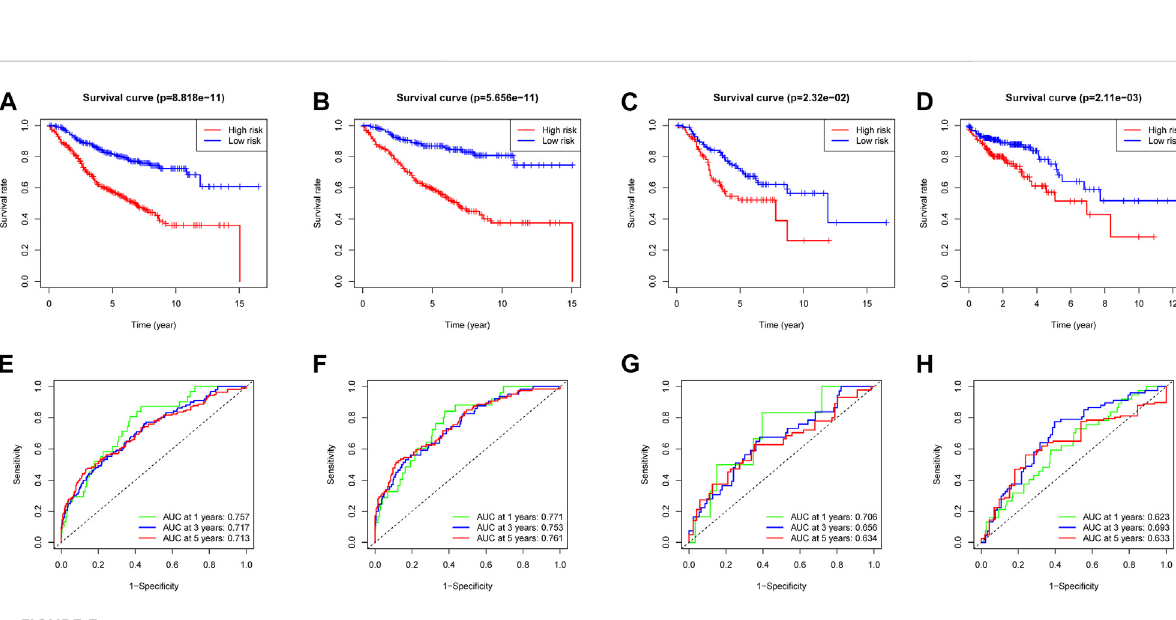
FIGURE 3 SurvivalanalysisandROC analysis oftworisk groupsofthe13-gene signature intraining cohort (A,E) ,testing cohort (B,F) ,all patients (C,G) ,and validation cohort (D,H)